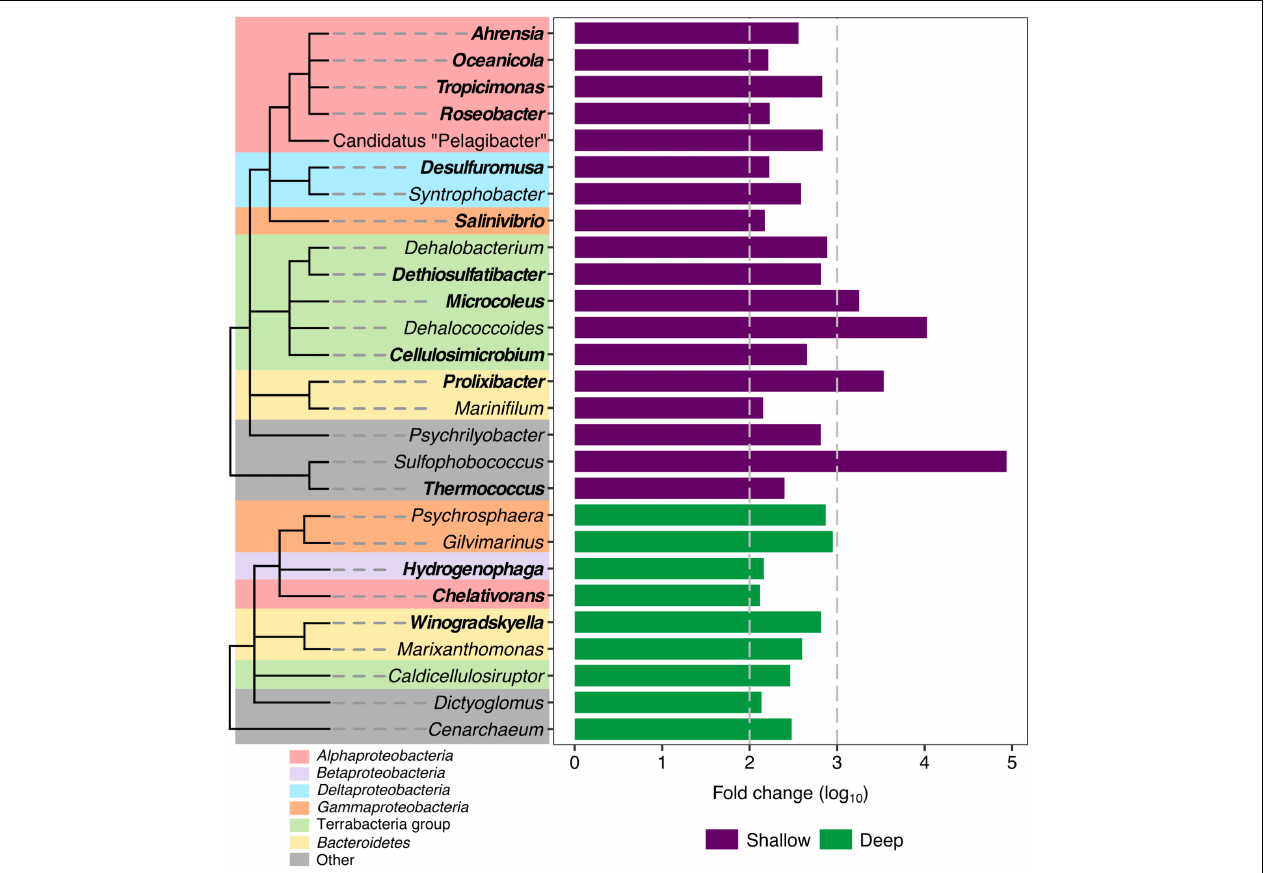
FIGURE 5 | Differentially abundant genera in shallow and deep samples from the swGoM. Bars represent the fold change abundance between deep (green) and shallow (purple) samples. Genera involved in hydrocarbon degradation are labeled in bold. Cladograms represent taxonomic associations among phylotypes; but branch lengths do not reflect phylogenetic